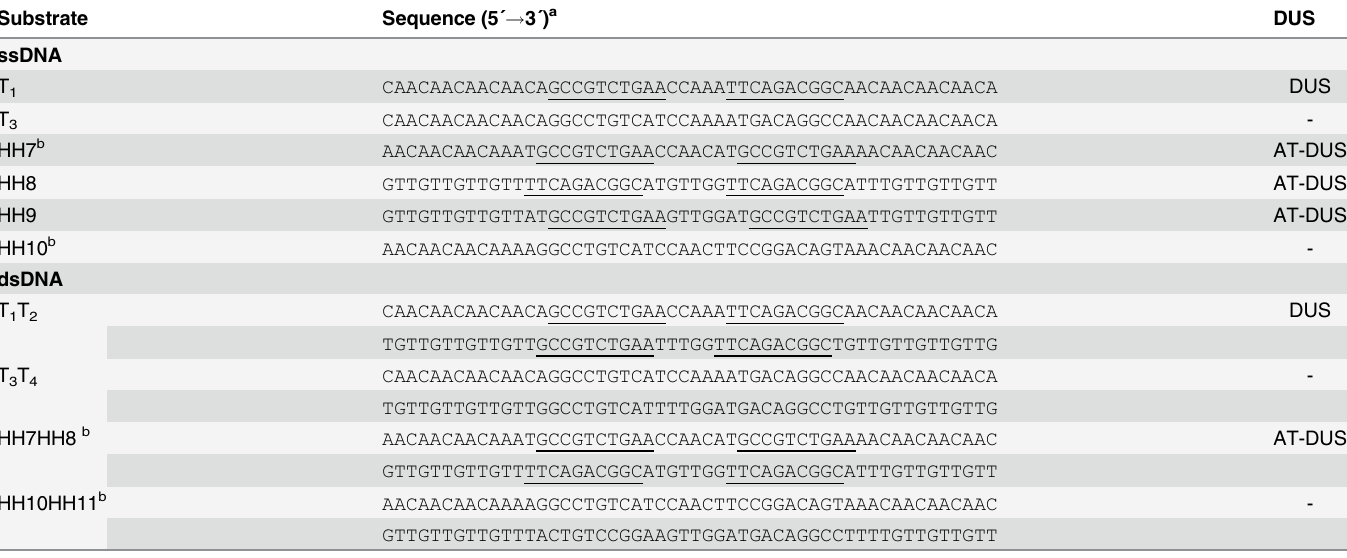
Table 2. DNA substrates employed in the